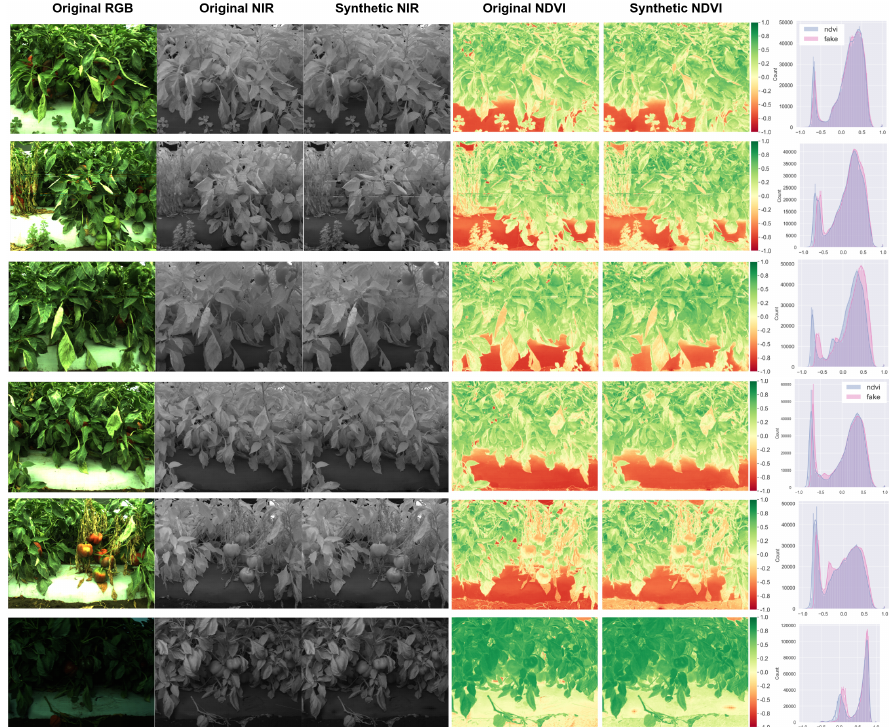
Figure 11. Six samples of capsicum dataset (1st and 2nd columns) and their corresponding synthetic NIR image (3rd) and NDVI images generated from original and synthetic NIR images (4th and 5th). The right most column shows pixel distribution for each NDVI images (red: synthetic, blue: